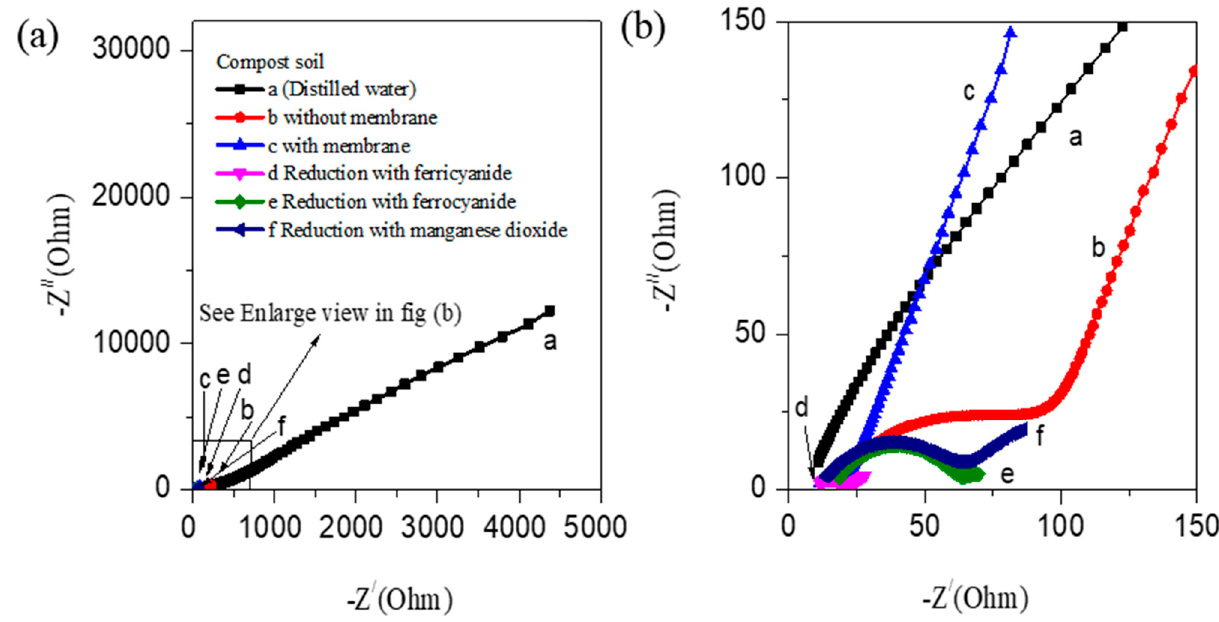
Figure 2. ( a ) EIS study showing the effect of different reducing agents using 0.2 g/mL fuel on different compost samples. ( b ) Enlarged view of the EIS curves.